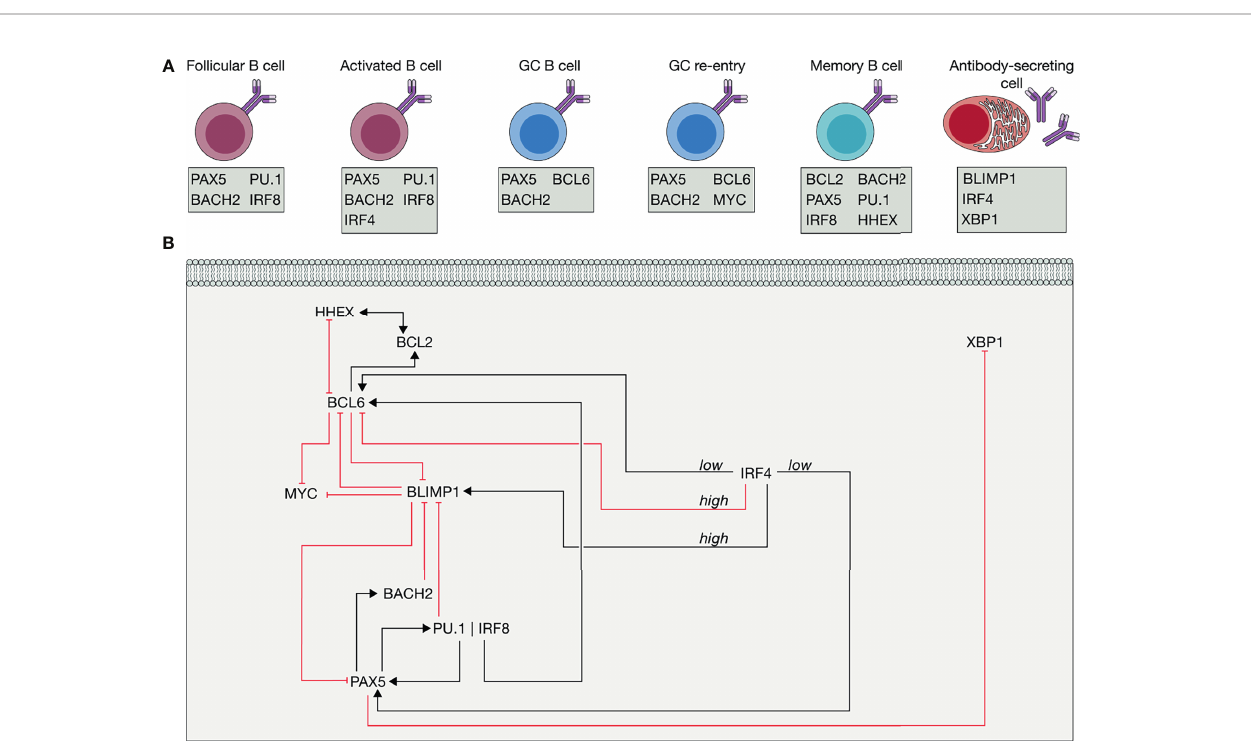
FIGURE 4 | Transcriptional control of the germinal center (GC) and differentiation. (A) Transcriptional pro fi le of follicular B cells, activated follicular B cells, GC B cells, GC B cells that re-enter into the GC reaction, high-af fi nity memory B cells (MBCs) and antibody secreting plasma B cells in terms of their phenotype-speci fi c marker genes. (B) Transcriptional regulation of GC continuation and differentiation. Activations (black lines with an arrow head) and inhibitions (red lines with a fl attened head) among genes and some proteins are shown. Relevant ones are: BTB and CNC homologue 2 (BACH2), B cell lymphoma 2 (BCL2), BCL6, B lymphocyte-induced maturation protein-1 (BLIMP1), Haematopoietically-expressed homeobox (HHEX), interferon-regulator factor 4 (IRF4), IRF8, Paired box protein 5 (PAX5) and X-box- binding protein 1 (XBP1) (see text for